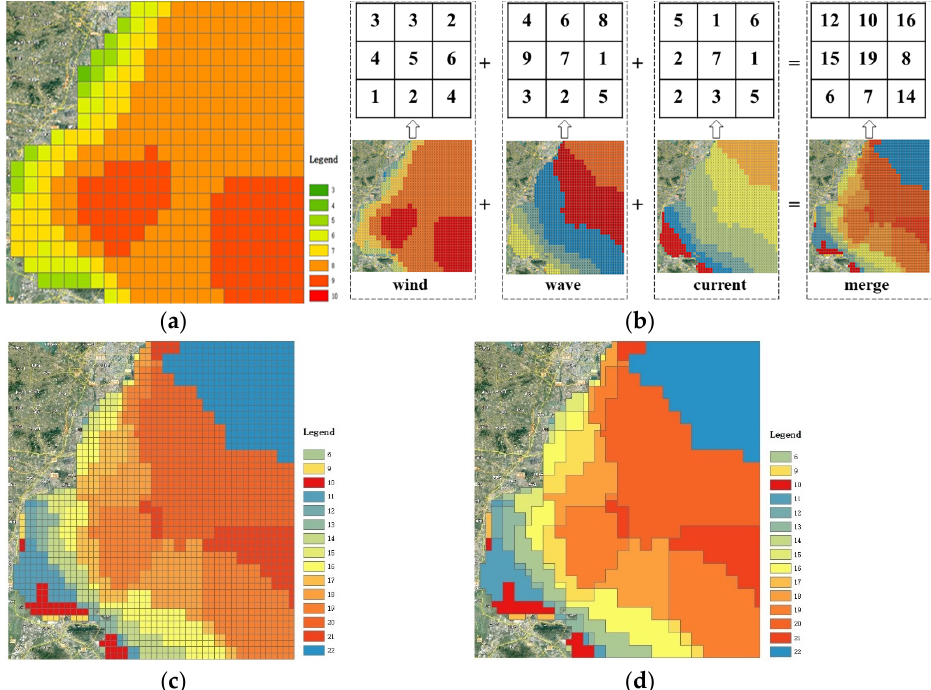
Figure 6. Construction of ocean data fusion grid. ( a ) Data reclassification; ( b ) schematic diagram of data merging; ( c ) data merging result; ( d ) data fusion results.